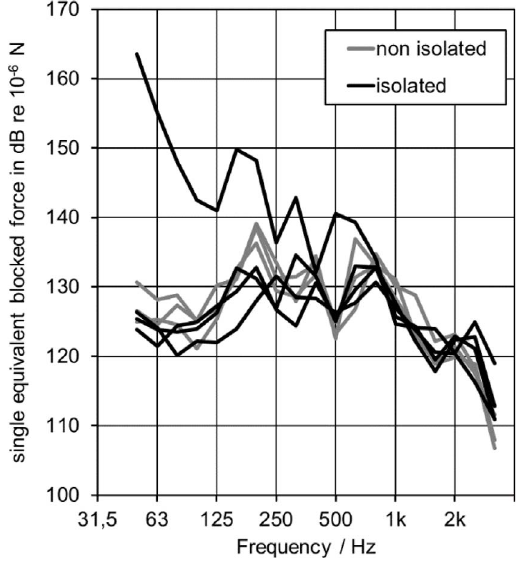
Figure 14. Measured single equivalent blocked force levels for the round robin reference source.